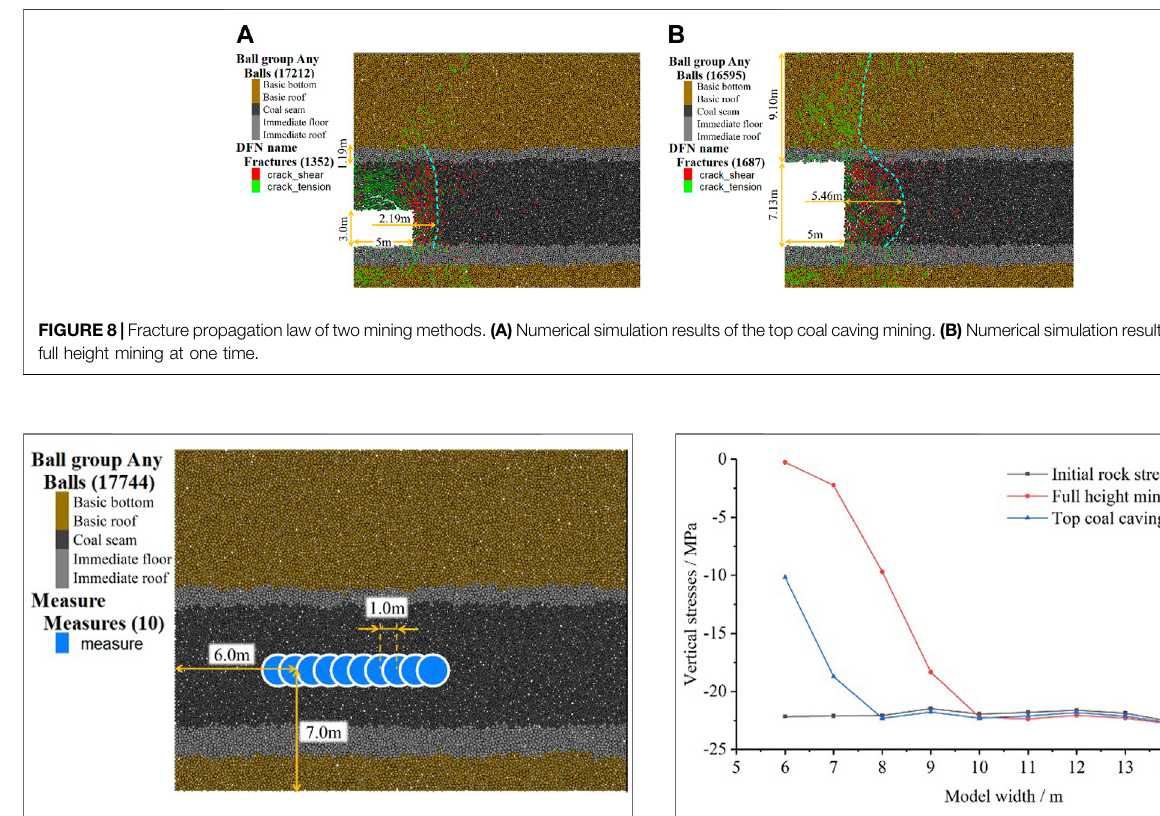
FIGURE 9 | Layout of stress measuring points in coal seam.